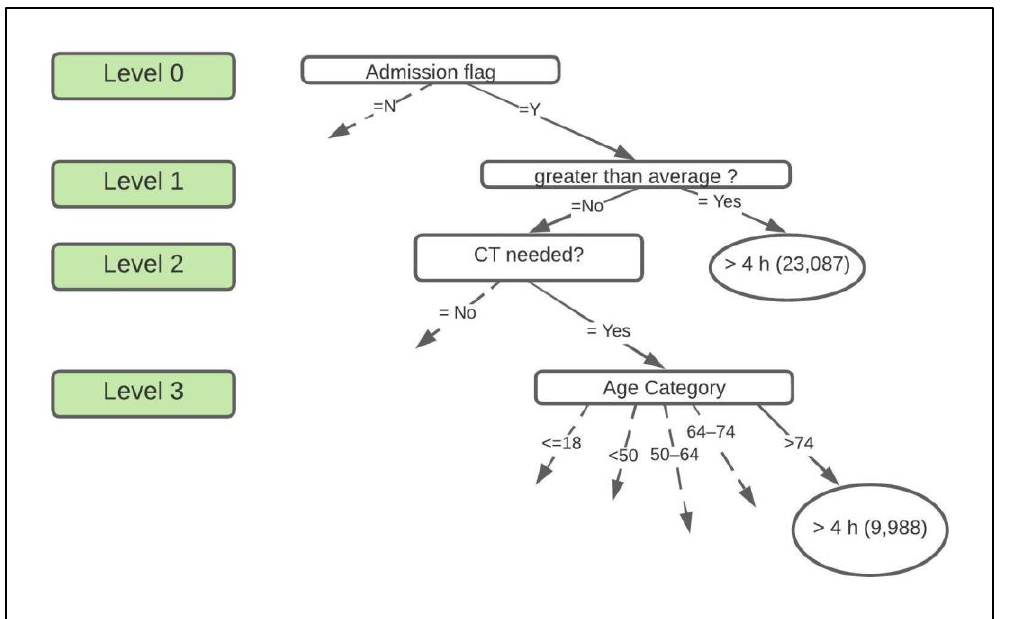
Figure 2. Portion of the decision tree. Note that the dotted lines indicate that the branch is connected to the rest of the tree. The ovals contain decisions, and the rounded rectangles contain the class.